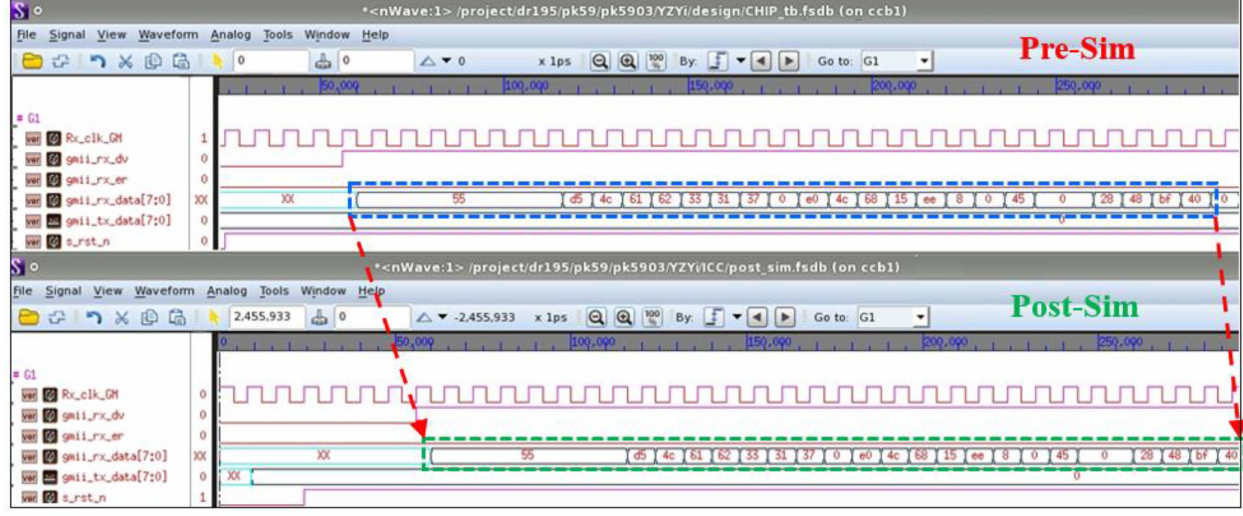
Figure 25. A comparison between pre-layout and post-layout simulations for receiving the Ethernet